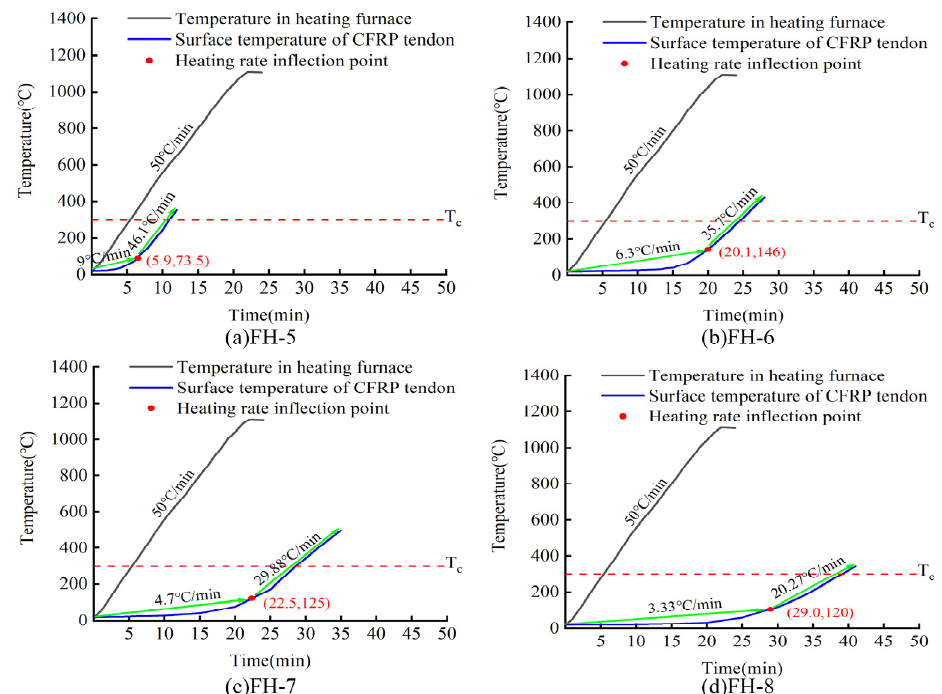
Figure 12. Heating curve of the surface of CFRP tendons wrapped with ceramic fiber felt of different thicknesses.